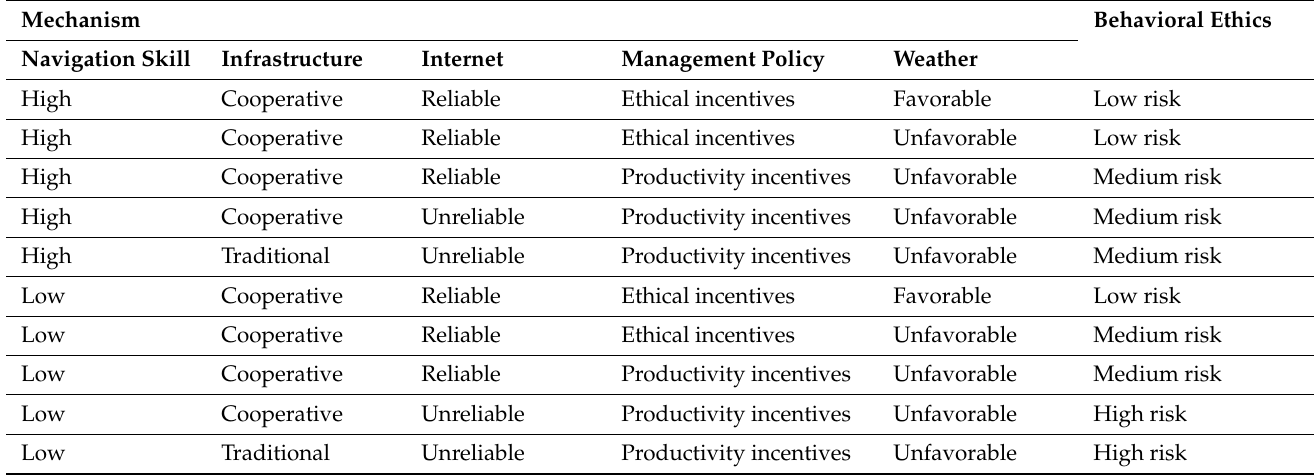
Table 3. Mechanism: Variables between navigational skill and behavioral